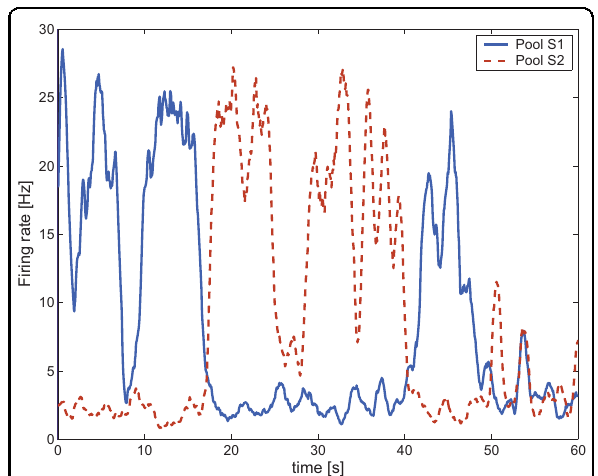
Fig. 5 Wandering between attractor states by virtue of statistical fl uctuations caused by the randomness of the spiking activity. We simulated a single long trial (60 s) in the spontaneous test condition for reduced NMDA and reduced GABA synaptic ef fi cacy (NMDA: − 1, GABA: − 1). The two curves show the activity of the two selective pools S1 and S2 over time smoothed with a 1 s sliding averaging window. The activity moves noisily between the attractor for the spontaneous state and the two high fi ring rate persistent attractor states S1 and S2. (Modi fi ed from Loh et al. 7